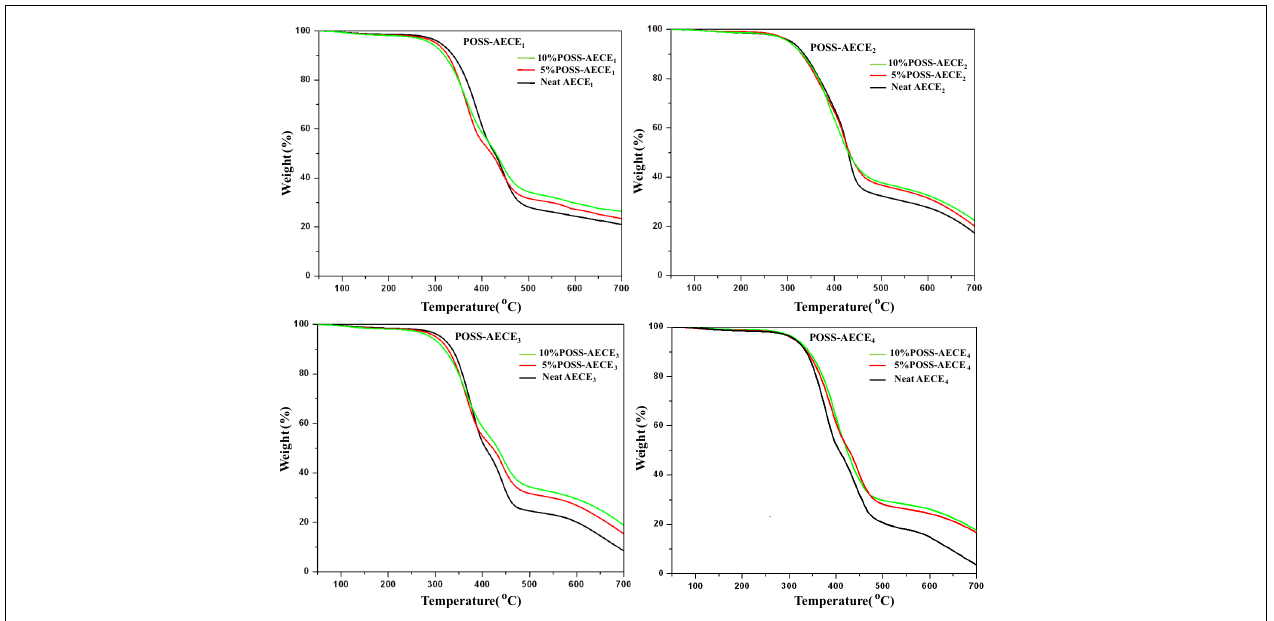
Figure 4 | TGA thermogram of POSS-AECE